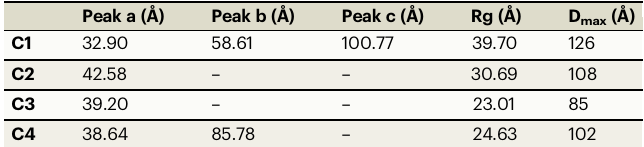
Table 1 | Parameters of P(r) curves using d-GFP@MOF- 919 (C1 –